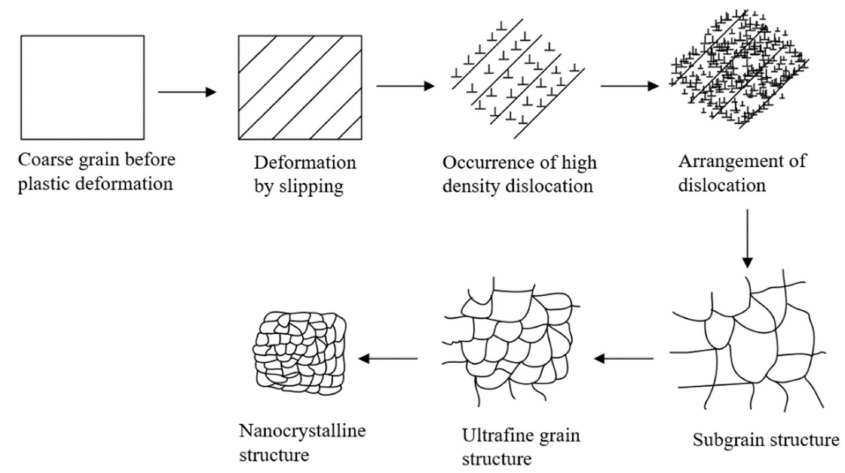
Figure 12. Formation process of microstructure refinement